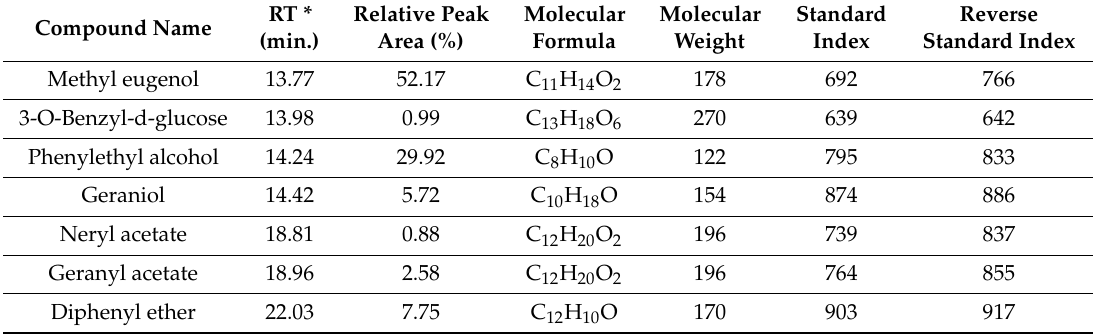
Table 1. Chemical composition of the oil from Rosa spp.